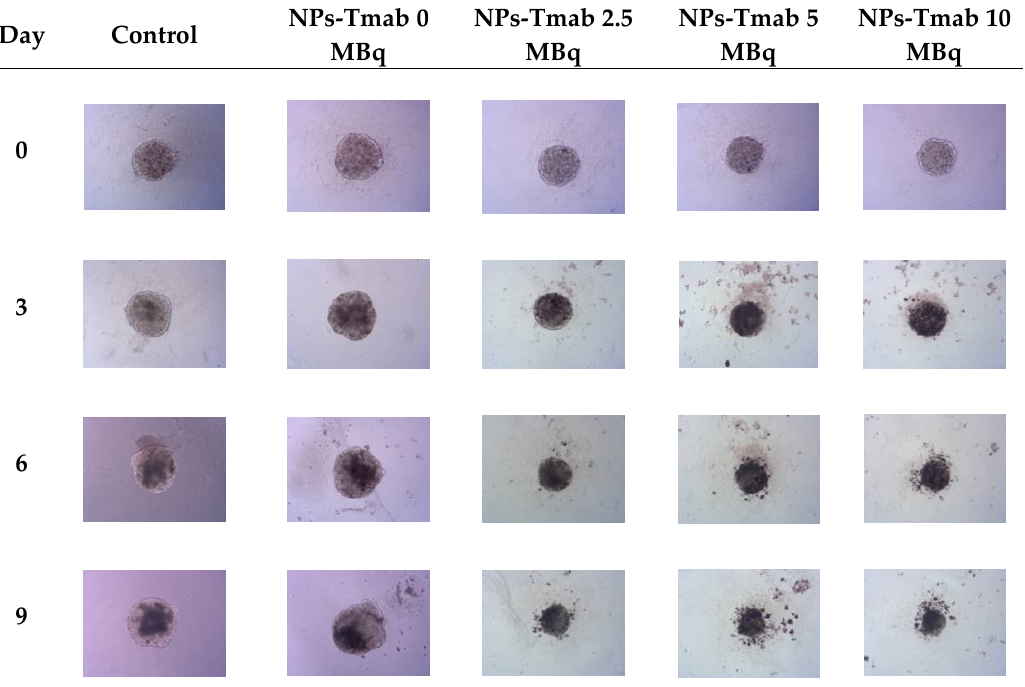
Figure 8. Microscope images of representative spheroids. Images made for spheroids incubated for 1 h with radioactive NPs-PEG on the day of treatment (Day 0) and on Days 3, 6 and 9 after treatment. Images were acquired with Primovert microscope equipped with Axiocam 105 color (Zeiss, Jena, Germany) with ZEN 2.3 lite software (Zeiss, Jena, Germany), 5× magnification.